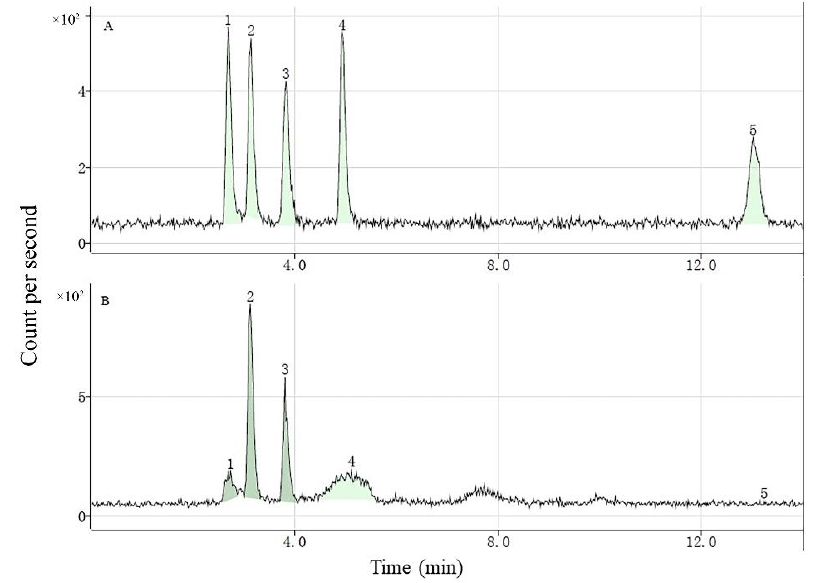
Figure 1. Chromatograms of different Se species of standard solution (5 µ g/L) ( A ) and Se-enriched soybean sprouts ( B ). SeCys 2 (1), MeSeCys (2), SeMet (3), selenite (4), and selenate